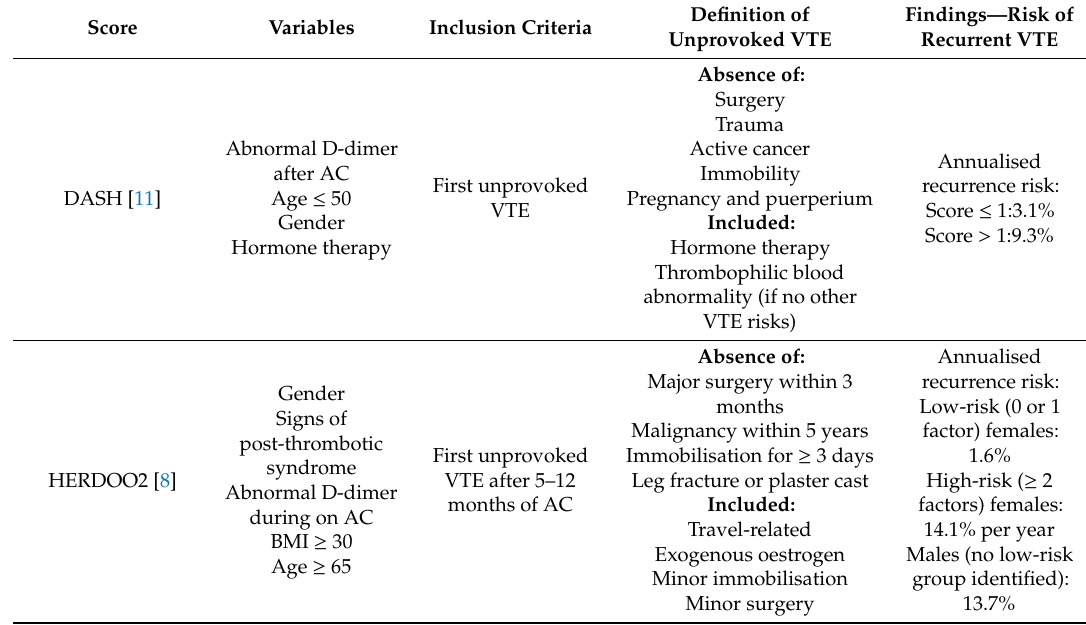
Table 1. Comparison of clinical prediction models for recurrent venous